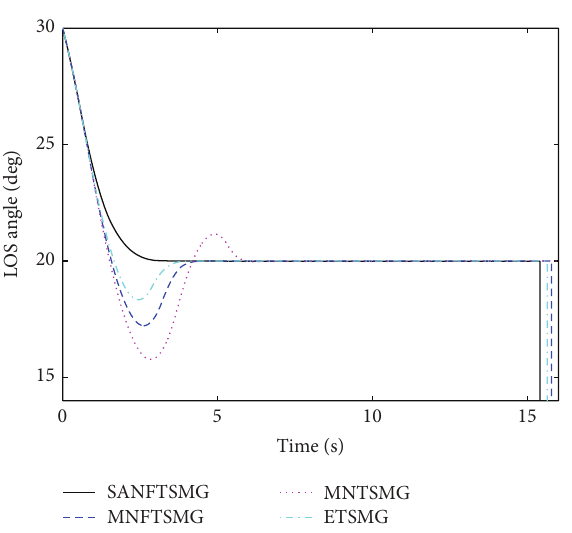
Figure 26: Sliding mode manifold (Case 2).